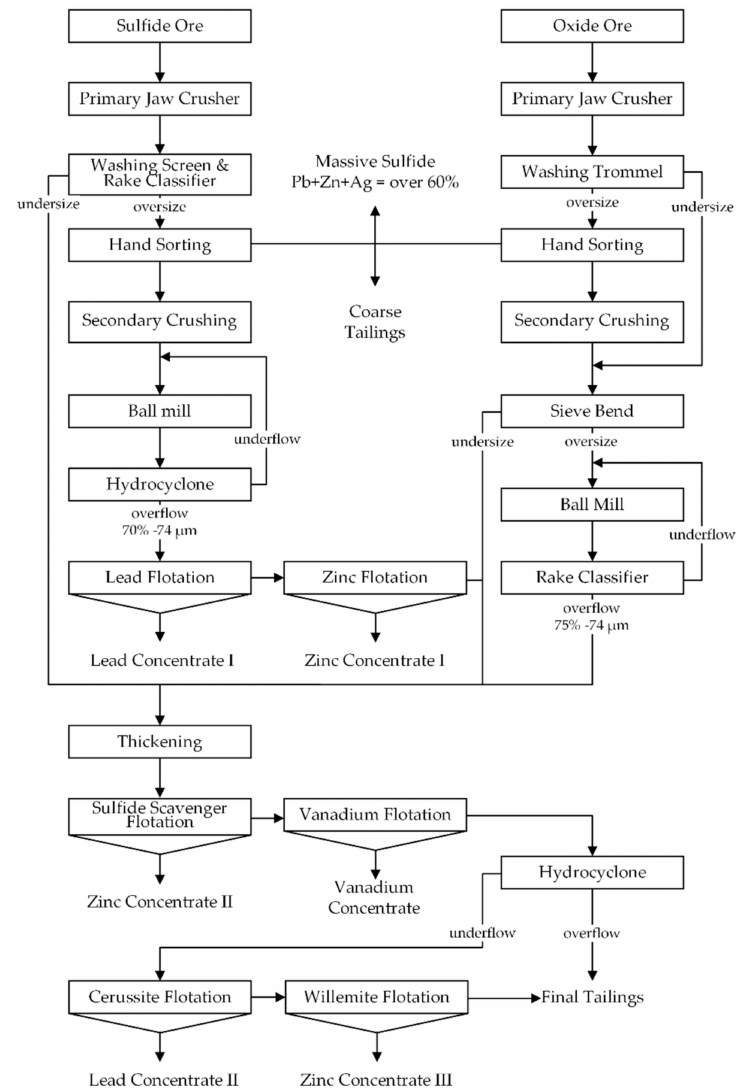
Figure 3. Flowsheet of processing plant at Berg Aukas Mine, Namibia